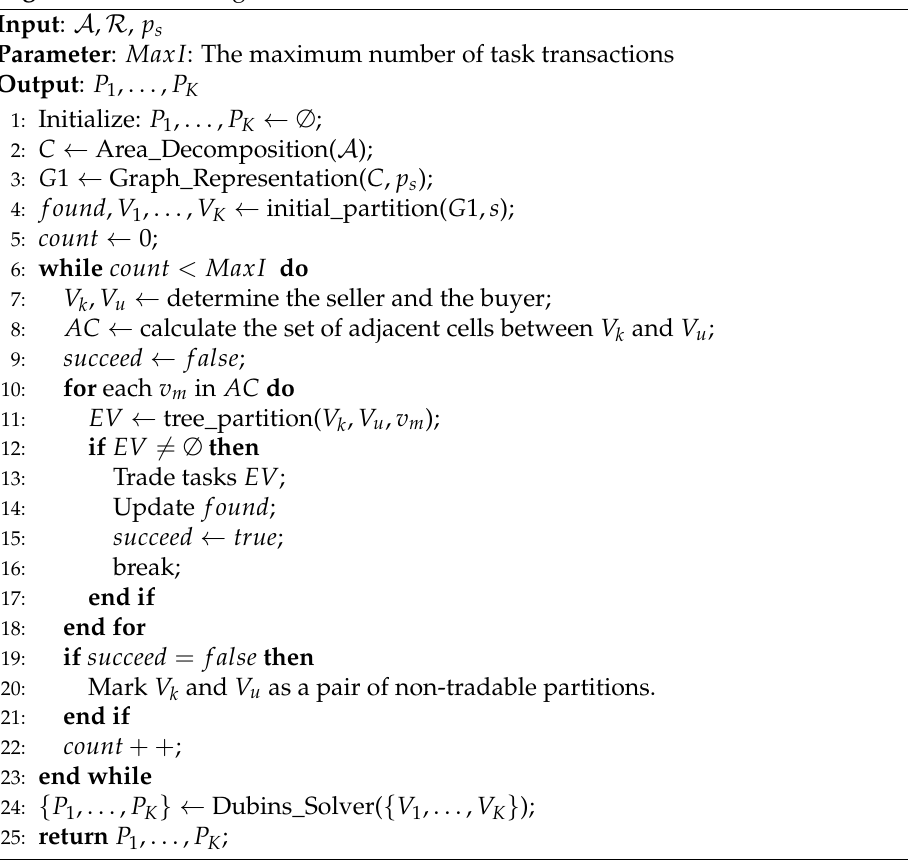
Algorithm 2 CDM